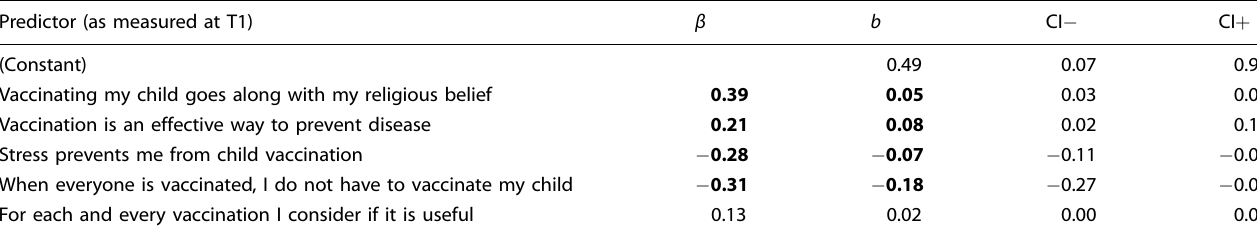
Table 3. Regression results at